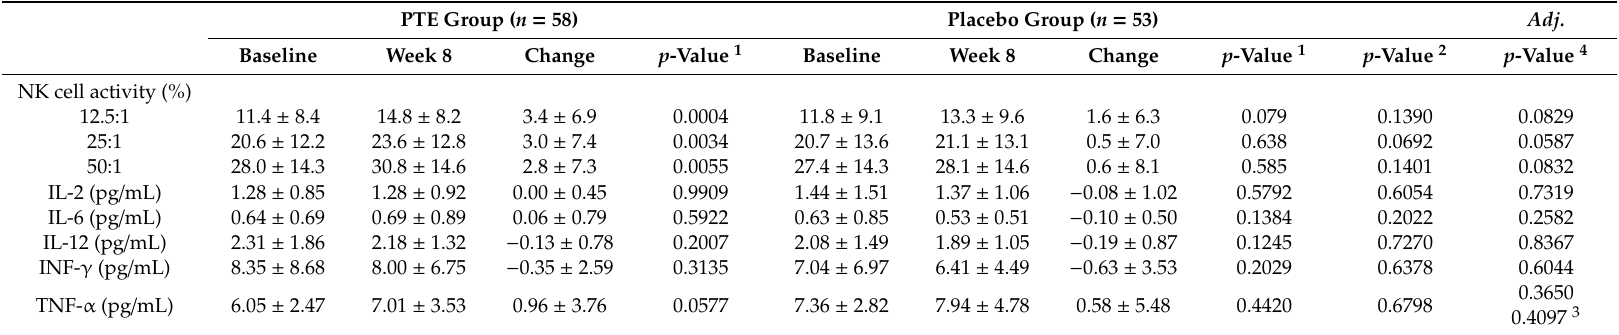
Table 4. NK cell activity and cytokine cluster analysis obtained prior to and after treatment in the two groups.